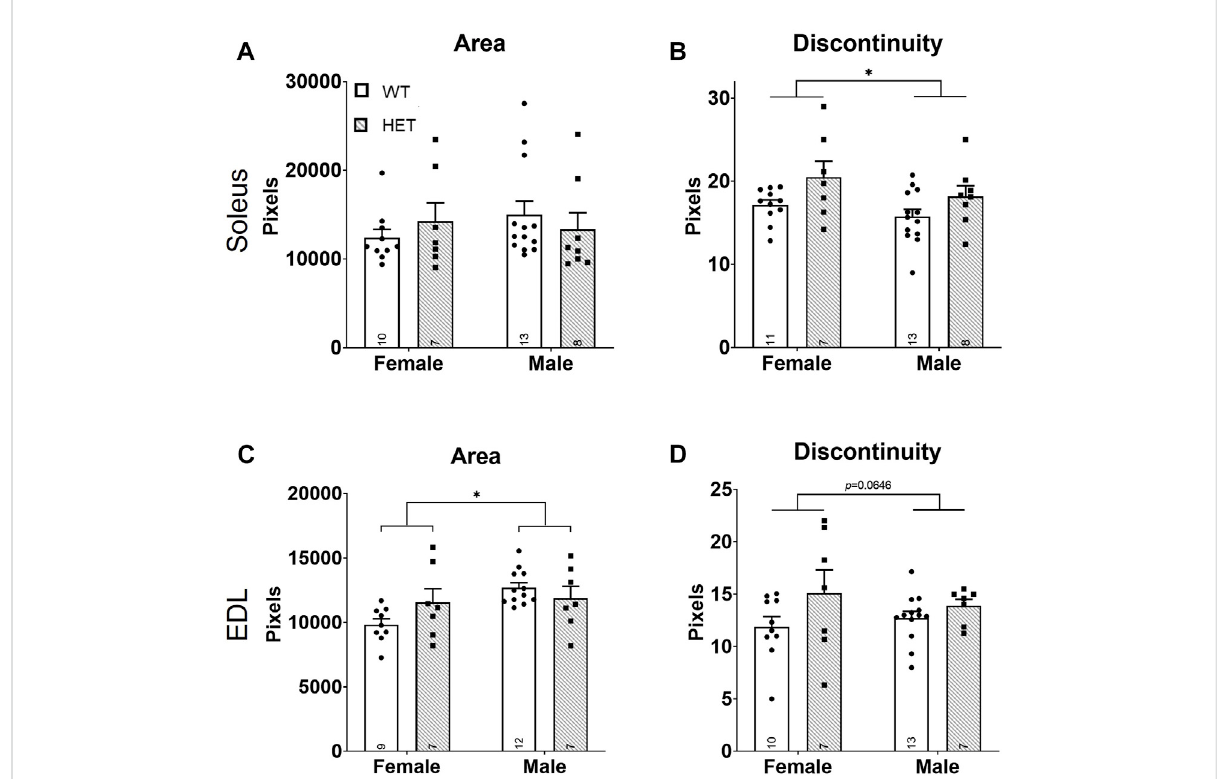
Increased NMJ fragmentation in HET skeletal muscles. Whole mount immuno fl uorescence staining for both nerve/vesicle and skeletal muscle portions of NMJs was performed at P44. Only data for skeletal muscle NMJ portions are shown. Graphs show total area (A,C) and calculatedNMJ discontinuity (B,D) for SOL (A,B) and EDL (C,D) skeletal muscles. Y-axes of graphsare numbersof pixels. WT :dots and open bars; HET : squares and grey hatched bars. * p < 0.05 (2-way ANOVA). Error bars show ±SEM; number of biological replicates are shown within each